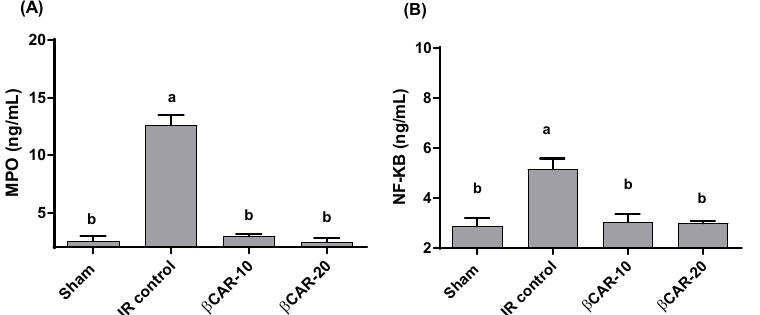
Figure 3. Effect of β CAR on MPO ( A ) and NF- κ B ( B ) in brains of rats with focal cerebral ischemia- reperfusion. a, b denotes significant difference at p ≤ 0.05 against sham and I/R control groups, respectively, ( n = 6).